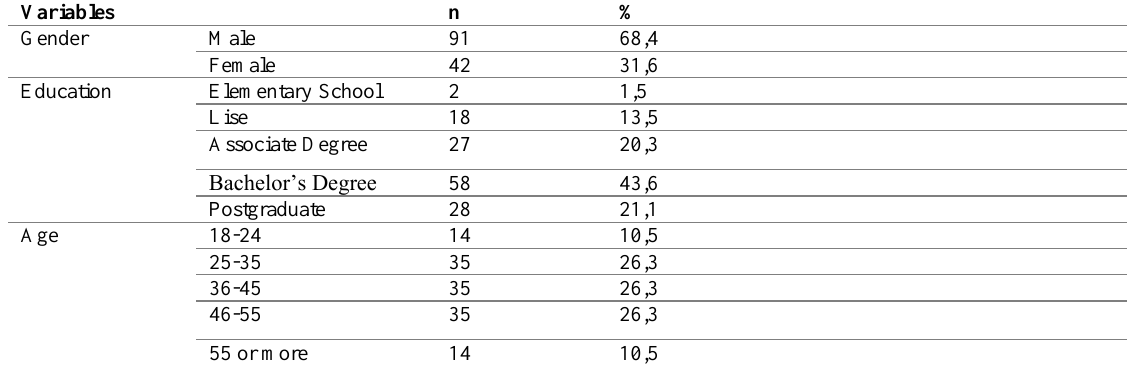
Table 2: Findings on Demographic Features